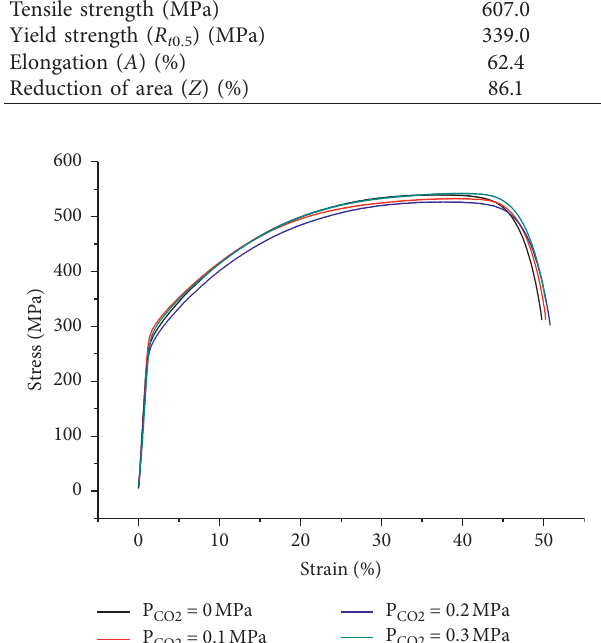
Figure 3: Stress-strain curve of 316L stainless steel at different CO partial